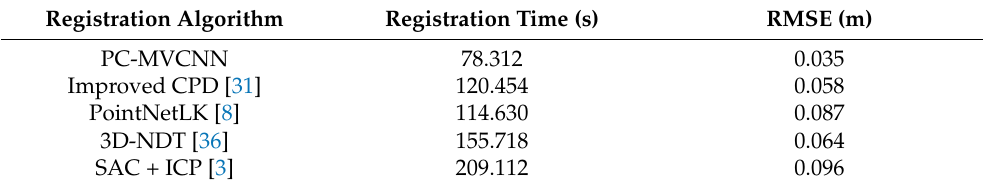
Figure 7. Local details of point cloud registration of WHU-TLS mountain dataset with different algorithms. ( a ) PC-MVCNN; ( b ) Improved CPD; ( c ) PointNetLK; ( d ) 3D-NDT; ( e ) SAC + ICP. Table 3. Registration results of various algorithms in WHU-TLS mountain dataset of Wuhan University.